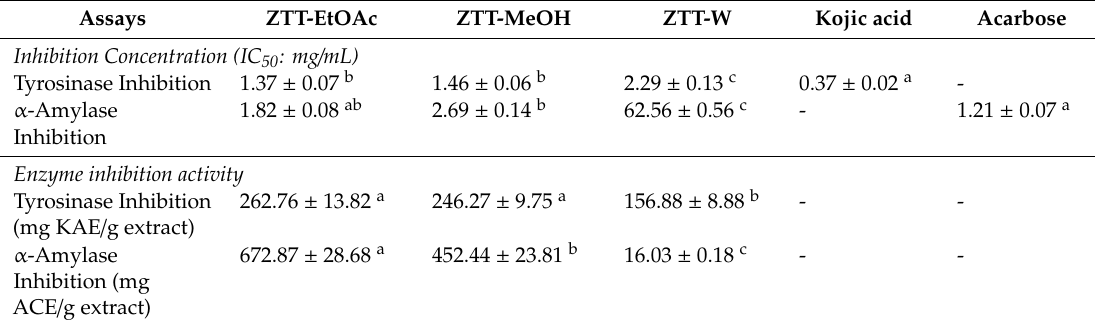
Table 4. Enzyme inhibition activities of standards and the solvent extracts from Z. taurica subsp. taurica x